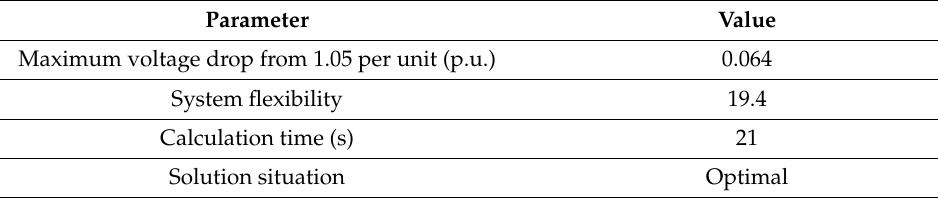
Figure 8. ( a ) Flexibility benefit, ( b ) operation cost in FC . Table 9. Convergence, operation, and flexibility results. Parameter Value Maximum voltage drop from 1.05 per unit